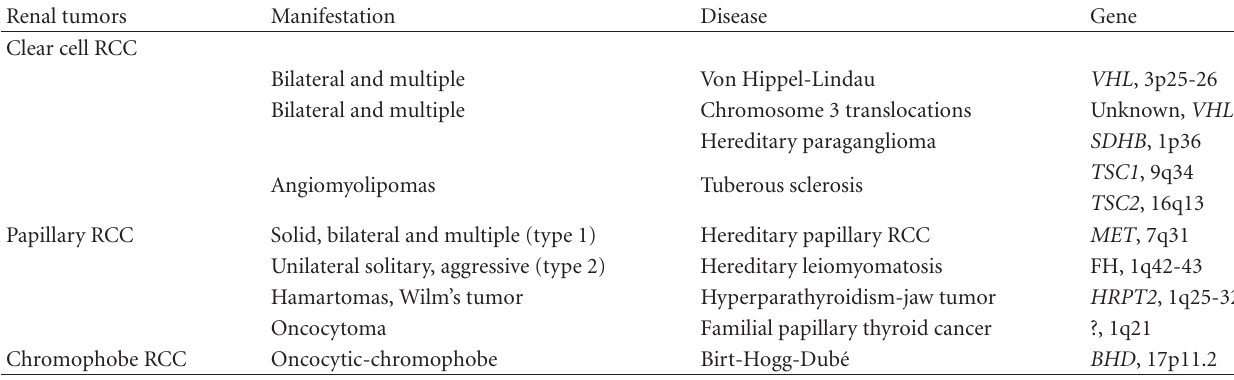
Table 2: Hereditary renal cell carcinoma (RCC) syndromes and histological